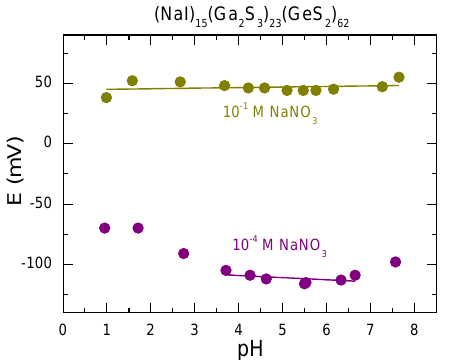
Figure 8. Influence of pH value on the potential of the sensor based on (NaI) 15 (Ga 2 S 3 ) 23 (GeS 2 ) 62 glass membrane for two different concentrations of the standard NaNO 3 solution, 10 − 1 M and 10 − 4 M. The lines are drawn as guides to the eyes.